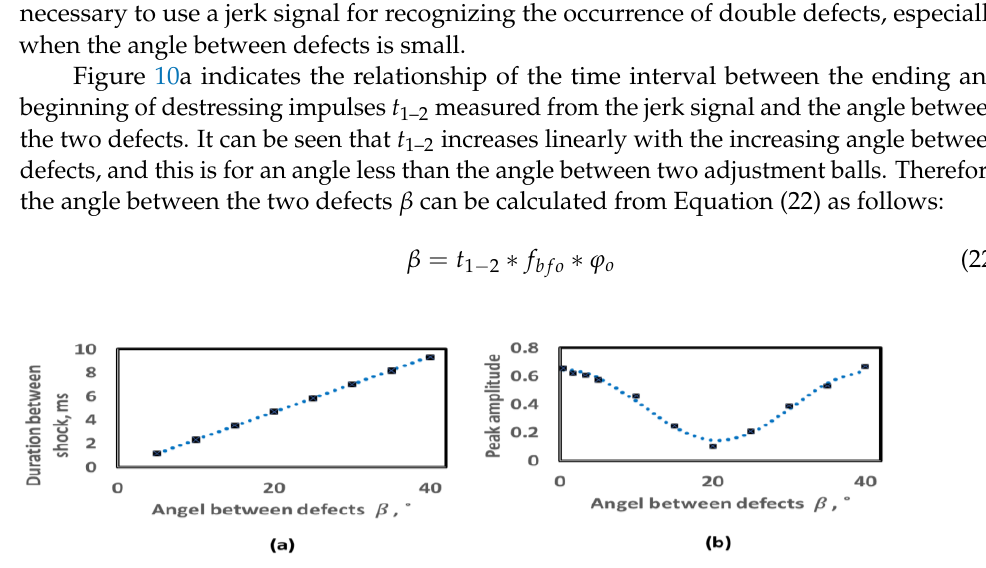
Figure 10. ( a ) Relationship between time interval t 1 – 2 and angle between defects β , and ( b ) relation- ship between peak amplitudes at BPFO and angle between defects β .